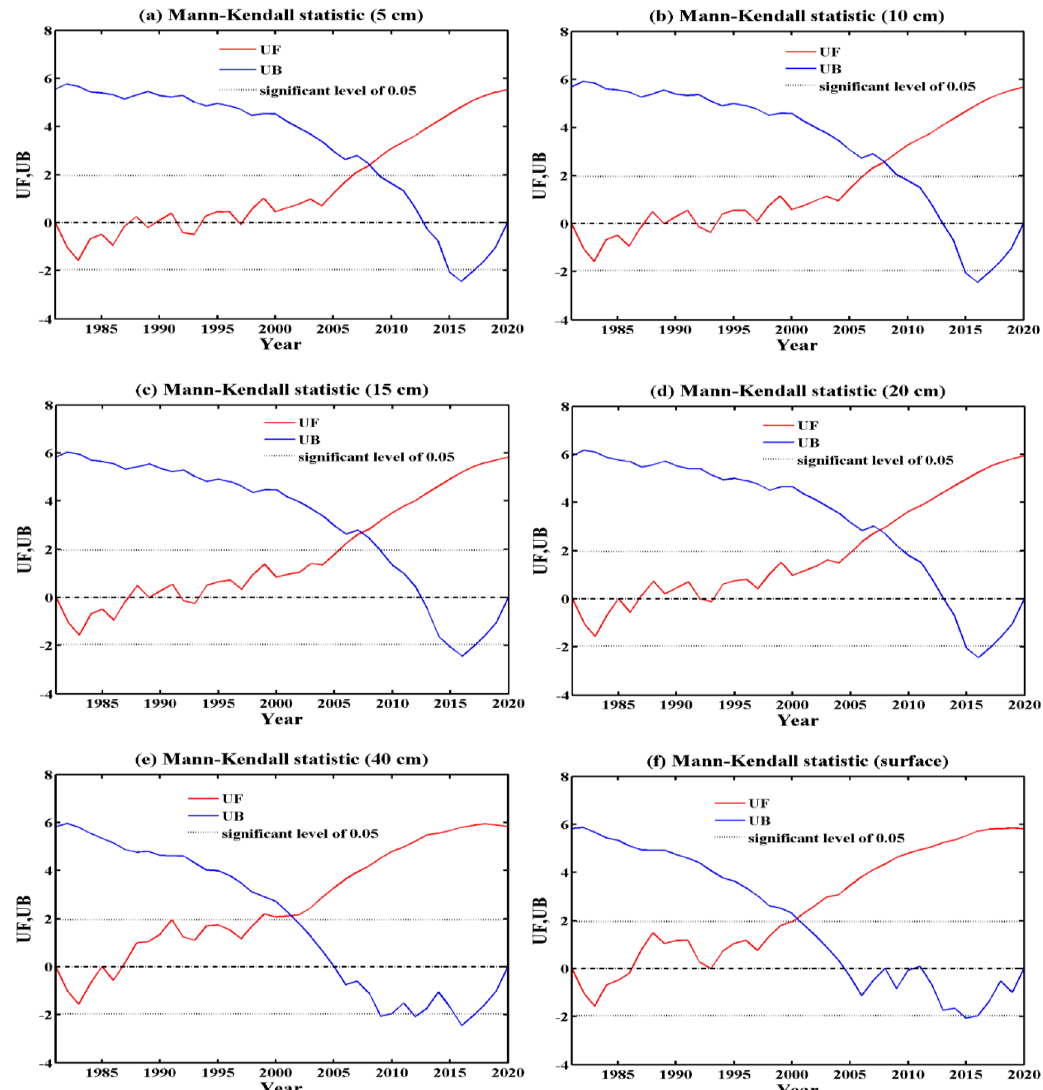
Figure 5. MK analysis of shallow ST on the Qinghai-Tibet Plateau. UF and UB are the statistics of the MK